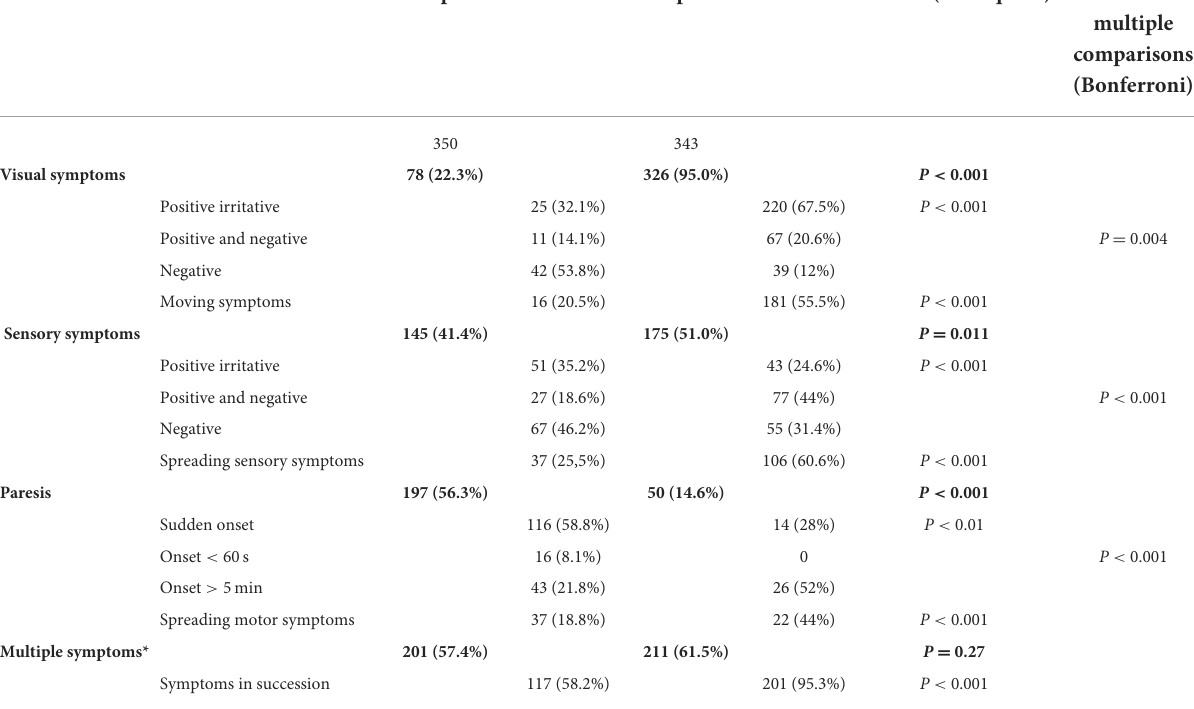
TABLE 2 Symptoms in stroke and MwA patients.